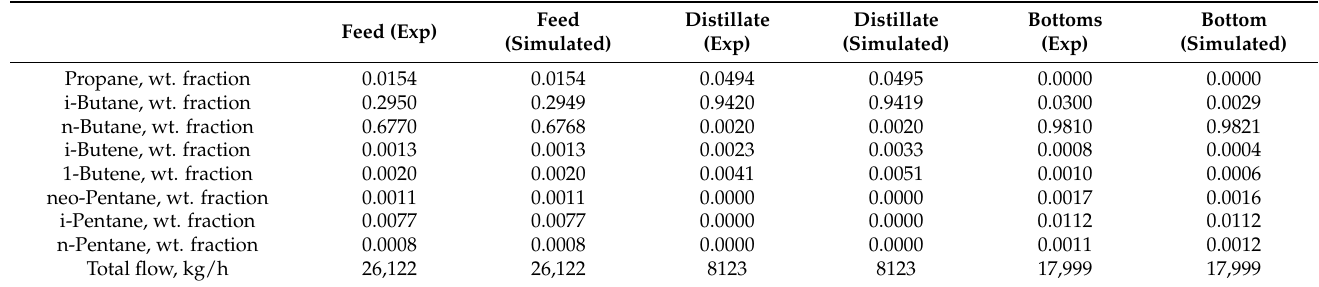
Table 1. Reconciled data of stream compositions and flows [38,39]. Feed (Exp)